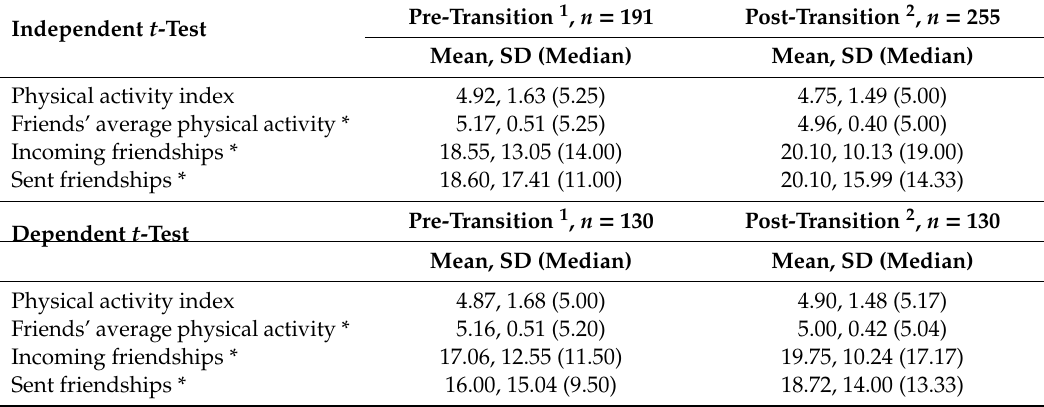
Table 2. Descriptive statistics for physical activity and friends’ characteristics of children with complete